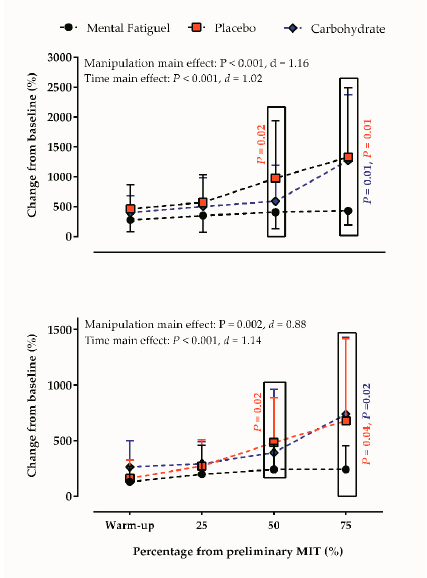
Figure 3. The prefrontal cortex (PFC, upper panel ) and motor cortex (MC, bottom panel ) activity throughout the maximal incremental test (MIT) during mental fatigue and mental fatigue combined with carbohydrate and placebo mouth rinse. Table 2. Maximal incremental test outcomes during mental fatigue, and mental fatigue combined with carbohydrate and placebo mouth rinses. Mental Fatigue Placebo Carbohydrate RER MAX 1.16 ± 0.06 1.17 ± 0.07 1.16 ± 0.07 RPE MAX 19.40± 0.99